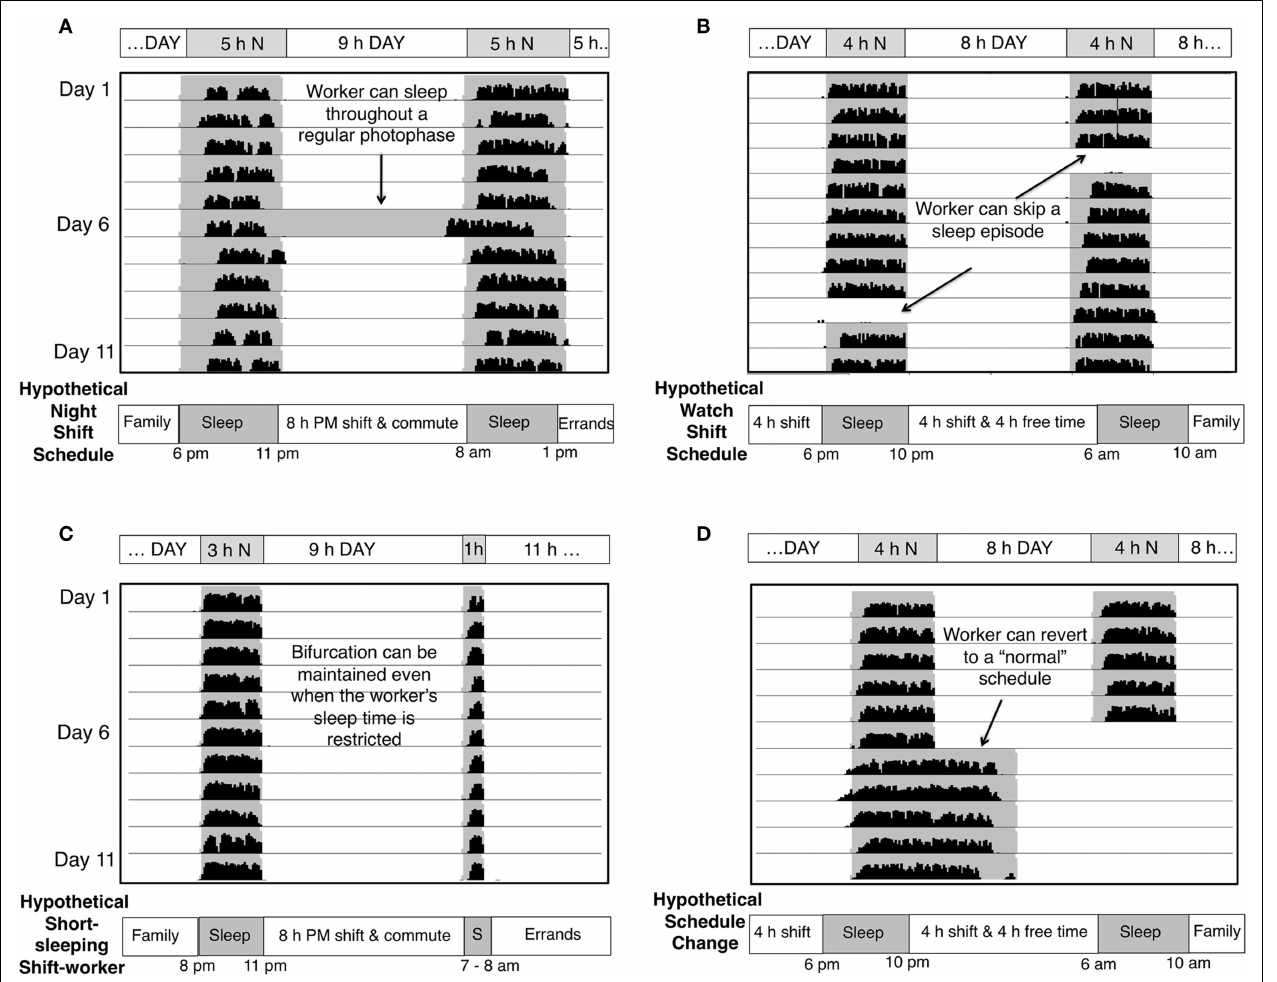
analogous human exposure would be a shift-worker sleeping through the environmental night on a day off or having a long sleep during the day. Note that scotophases do not have to be evenly spaced within 24h. (B) Removal of a photophase (A) – analogous to a shift-worker sleeping in on a day off–or a scotophase (B) – analogous to a shift-worker staying up all day on a day off–does not compromise the stability of the bifurcated state of entrainment. (C) Scotophases do not have to be of equal length, and bifurcation remains stable even when the bouts are asymmetrical and greatly reduced in length. (D) Bifurcated animals can revert to a normal, diurnal rhythm within one